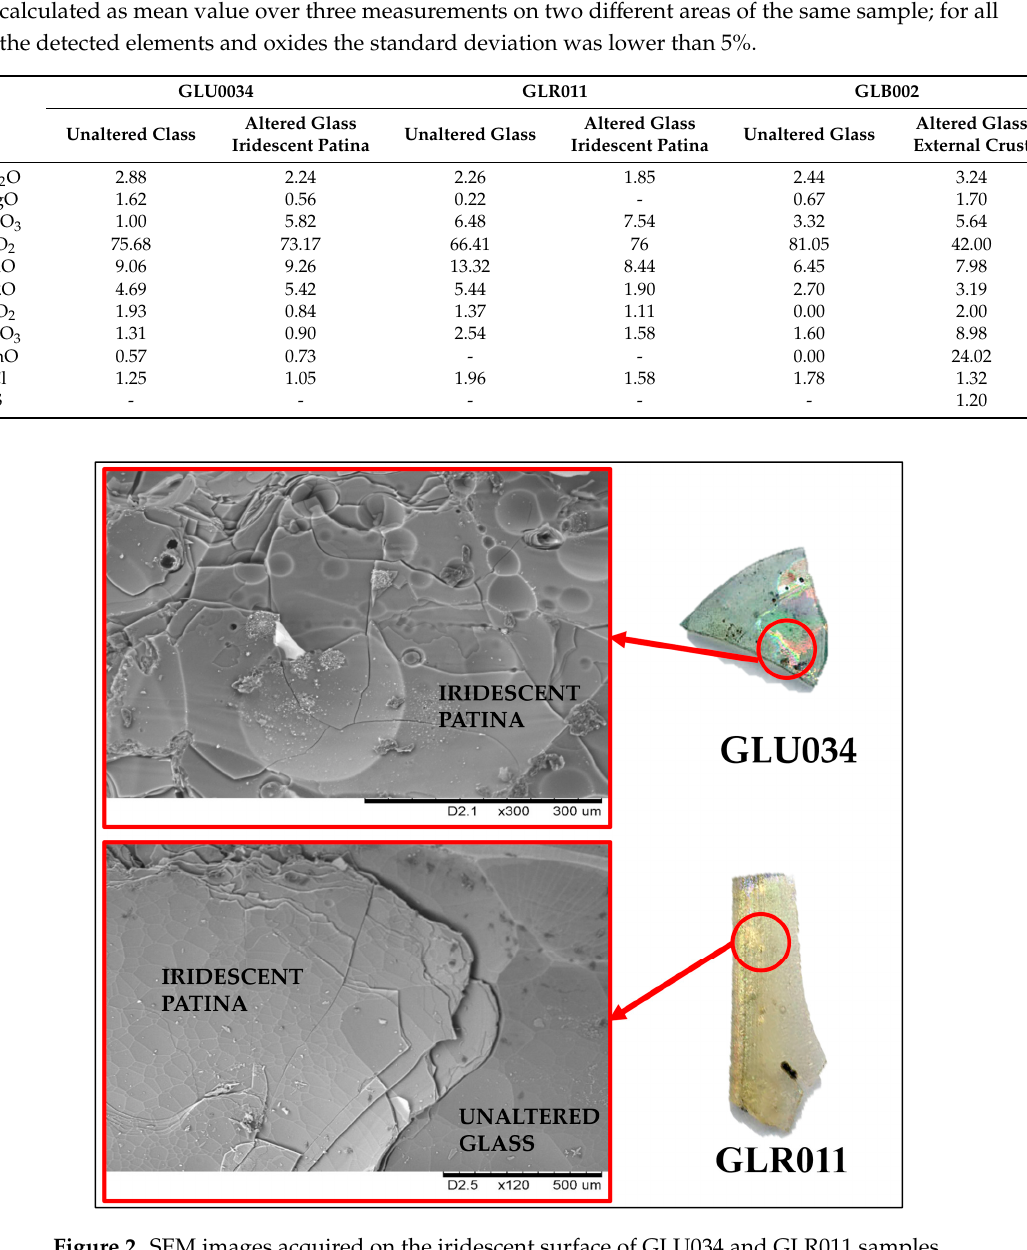
Figure 3. Mean concentrations (wt%) detected by SEM-EDS of the elements present on the altered (iridescent area) and unaltered area of sample GLR011.